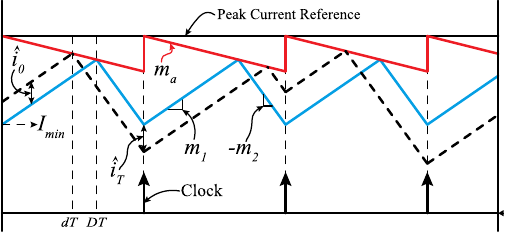
Figure 6. Slope compensation on the secondary-side inductor current to suppress sub-harmonic oscillation.